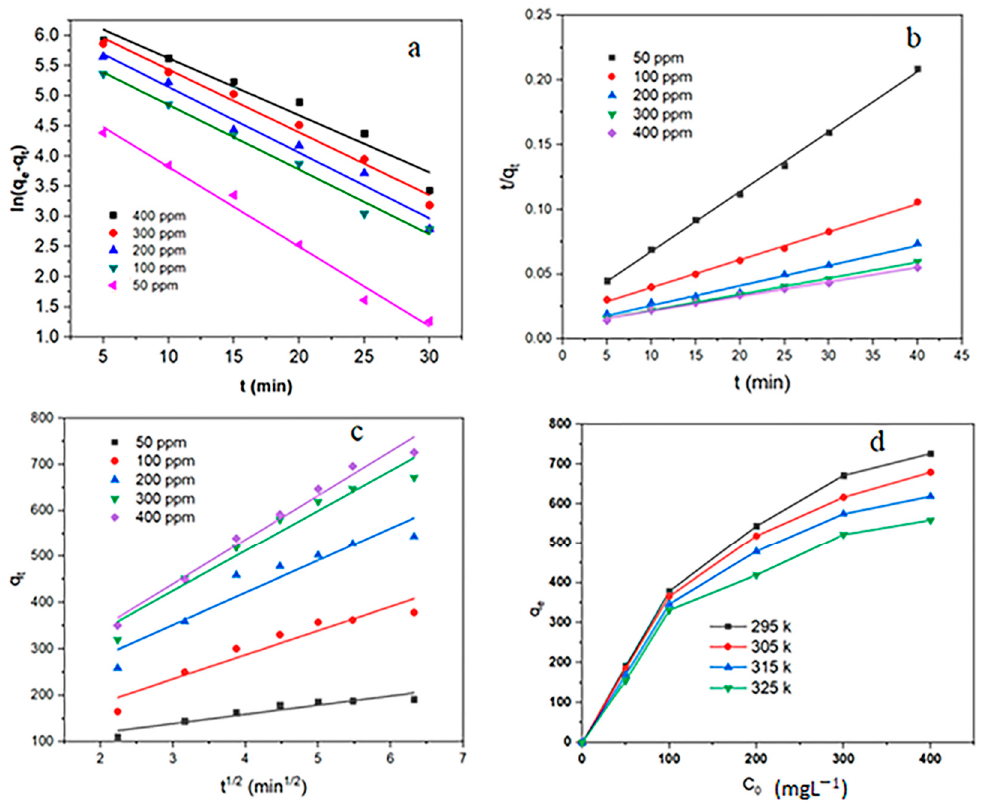
Figure 8. Plot of ( a ) pseudo-first-order kinetic isotherm, ( b ) pseudo-second-order kinetic isotherm, ( c ) intraparticle model, and ( d ) adsorption isotherms for the RhB adsorption on MIL-100(Fe) @Fe 3 O 4 @AC.